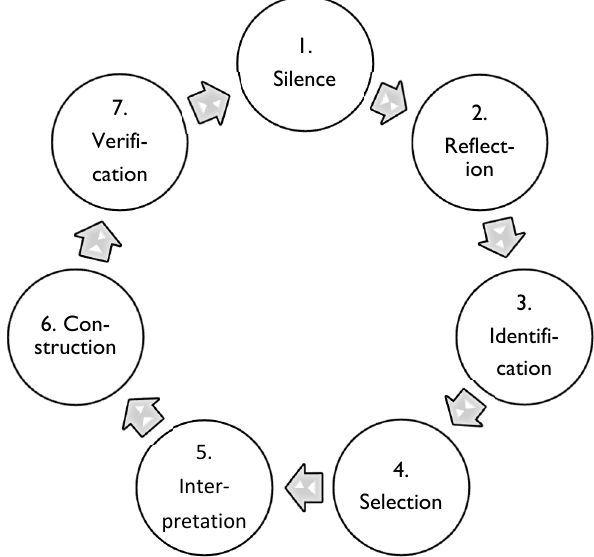
Figure 1. The research process of phenomenology in the Vancouver School ([39], p. 56). Reprinted with permission from Ref. [39]. 2000, Sigridur Halldorsdottir. This cycle is repeated in every step of the research process of the Vancouver School method.